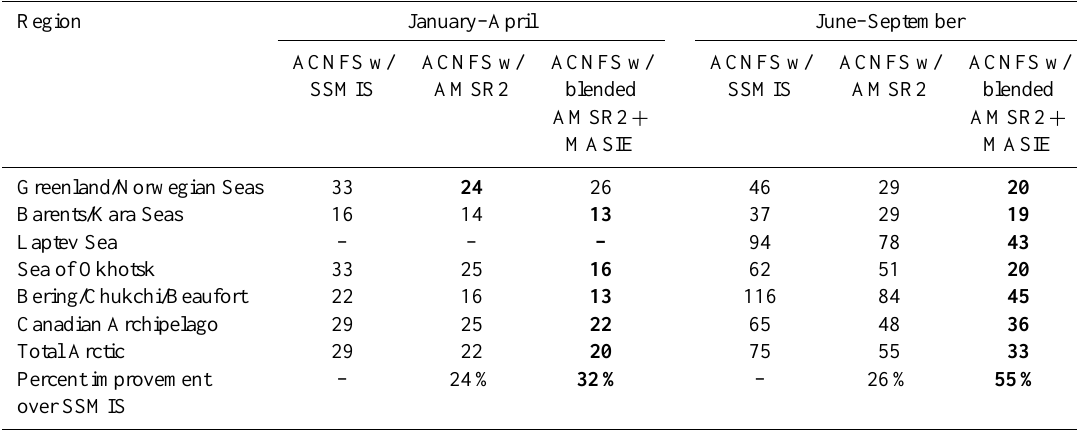
Table 2. Seasonal mean distance differences (km) between the NIC ice edge and 6h ACNFS forecasts initialized from various combinations of SSMIS, AMSR2 and IMS data for the time periods January–April and June–September. The bottom row shows the total Arctic percent improvement from each ice forecasting system compared to using SSMIS assimilation alone. The Laptev Sea is fully ice-covered in the winter season and no ice edge analysis was performed. The bold numbers denote the smallest mean distance error between the assimilation test cases.